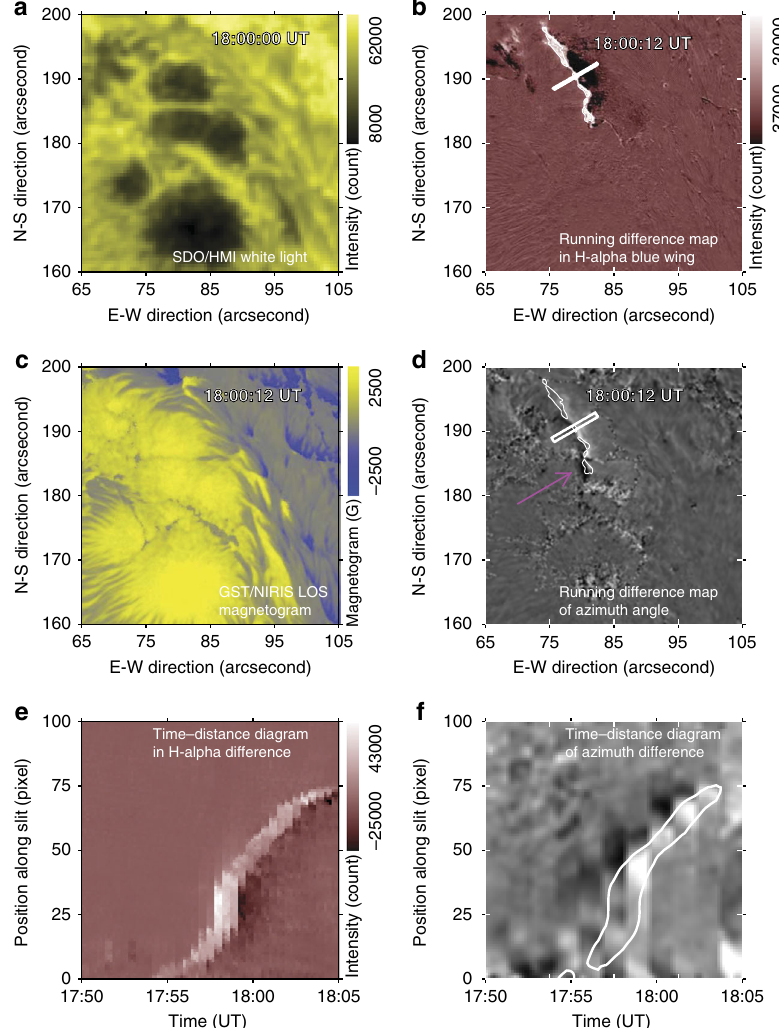
Fig. 1 Azimuth angle changes in association with Flare emission. All of the four images ( fi rst and second rows) were taken simultaneously at the fl are peak time (18:00 UT) in a common FOV of 40 ʺ by 40 ʺ . a SDO/HMI white light map. Running difference image in H α blue wing ( − 1.0 Å), showing the eastern fl are ribbon in ( b ). The bright part is the leading front and the dark component is the following component. c The GST/NIRIS LOS magnetogram, scaled in a range of − 2500 (blue) to 2500 G (yellow). Running difference map of azimuth angle generated by subtracting the map taken at 17:58:45 UT from the one taken at 18:00:12 UT in ( d ). The dark signal pointed to by the pink arrow represents the sudden, transient increase of azimuth angle at 18:00:12 UT. The white contours outline 60% of the maximum emission of the H α ribbon front. e Time – distance diagram of H α difference maps. The slit position is shown in ( b ). The time period is from 17:50 UT to 18:05 UT. f Time – distance diagram of azimuth difference maps. The slit position is shown in ( d ). The time period is from 17:50 UT to 18:05 UT. The white contours outline 15% of the maximum emission of the H α ribbon front in ( e